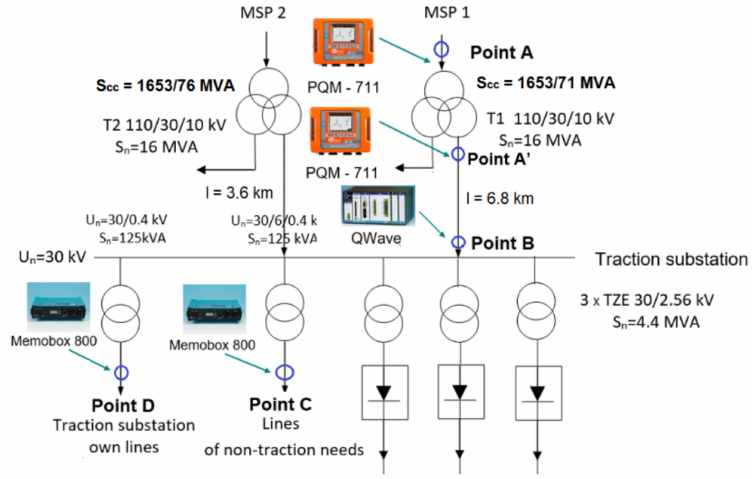
Figure 1. Registration points for indicators characterizing the power quality. Points A and A (cid:48) are located at the Main Supply Point (MSP). Point A is the primary side of a transformer with rated voltage U n = 110 kV. Point A (cid:48) is on the secondary side of a transformer with rated voltage U n = 30 kV. The traction substation is powered by two overhead lines with a voltage of Un = 30 kV. The primary power line with a length of l 1 = 6.8 km connects the traction substation with MPS 1. The backup power supply is